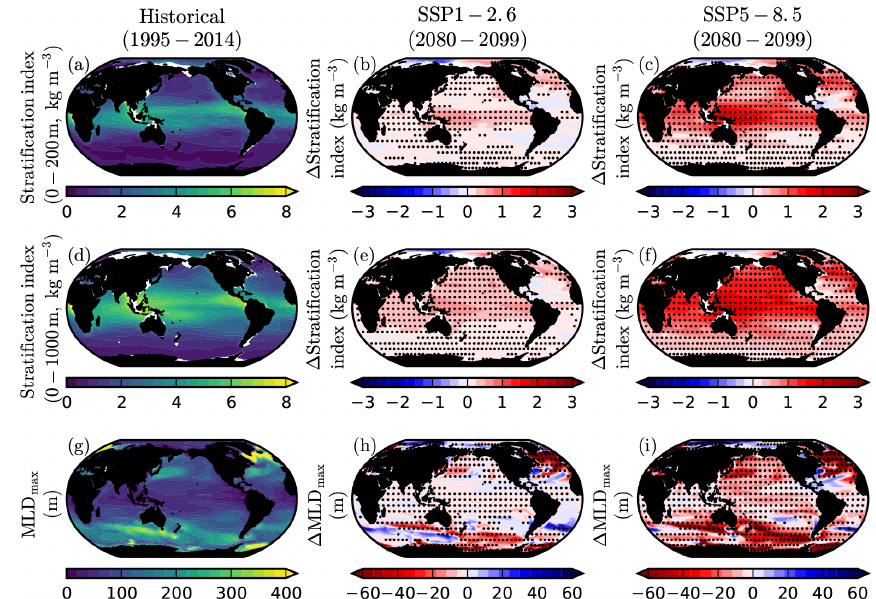
Figure 4. Change in stratification and mixed-layer depth in SSP1-2.6 and SSP5-8.5. CMIP6 mean historical climatologies and anomalies in (a–c) stratification index between 200m and the surface (kgm − 3 ), (d–f) stratification index between 1000m and the surface (kgm − 3 ), and (g–i) maximum annual mixed-layer depth (m). Anomalies are 2080–2099 mean values relative to 1995–2014. The stratification index is defined as the difference in density between given depths and the surface. Stippling designates robustness, as defined by the magnitude of the mean anomaly exceeding the inter-model